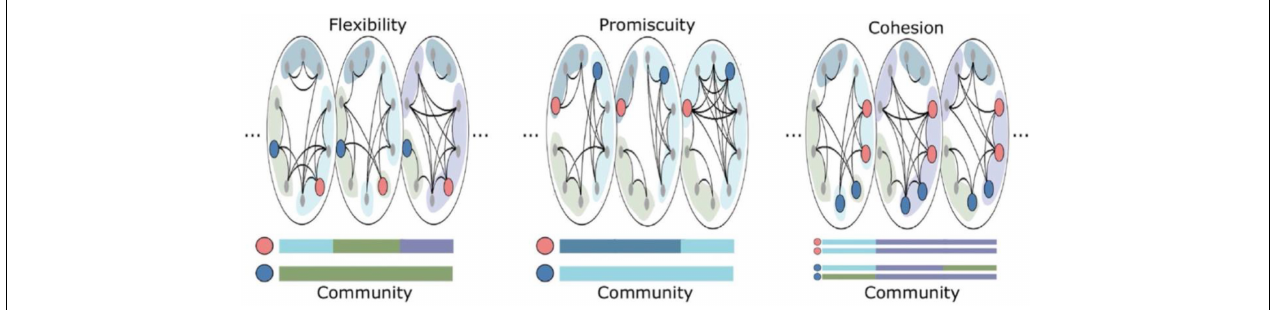
FIGURE 5 | Reprinted with permissions from Sizemore and Bassett (2018). This schematic depicts examples of nodes with low (dark blue) or high (pink) flexibility, promiscuitiy, and cohesion. In the (Left) panel, the pink node is more flexible than the blue node (i.e., changes communities more often). In the (Middle) panel, the pink node has higher promiscuity than the blue node (i.e., visits a greater proportion of available communities across time). In the (Right) panel, the pink nodes have higher cohesion strength than the blue nodes (i.e., the pink nodes move between communities in tandem).